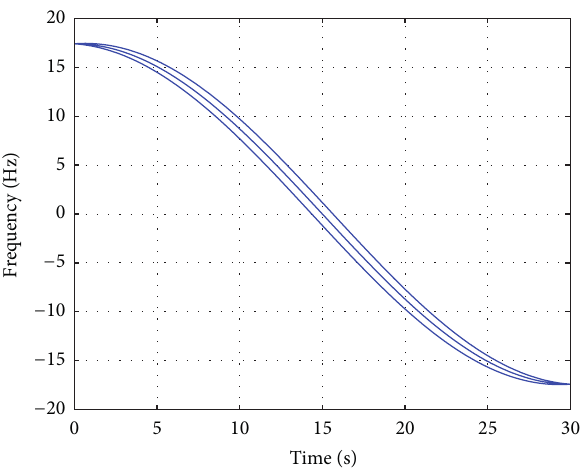
Figure 8: The Doppler frequency curves of the moving target in the flat earth model.